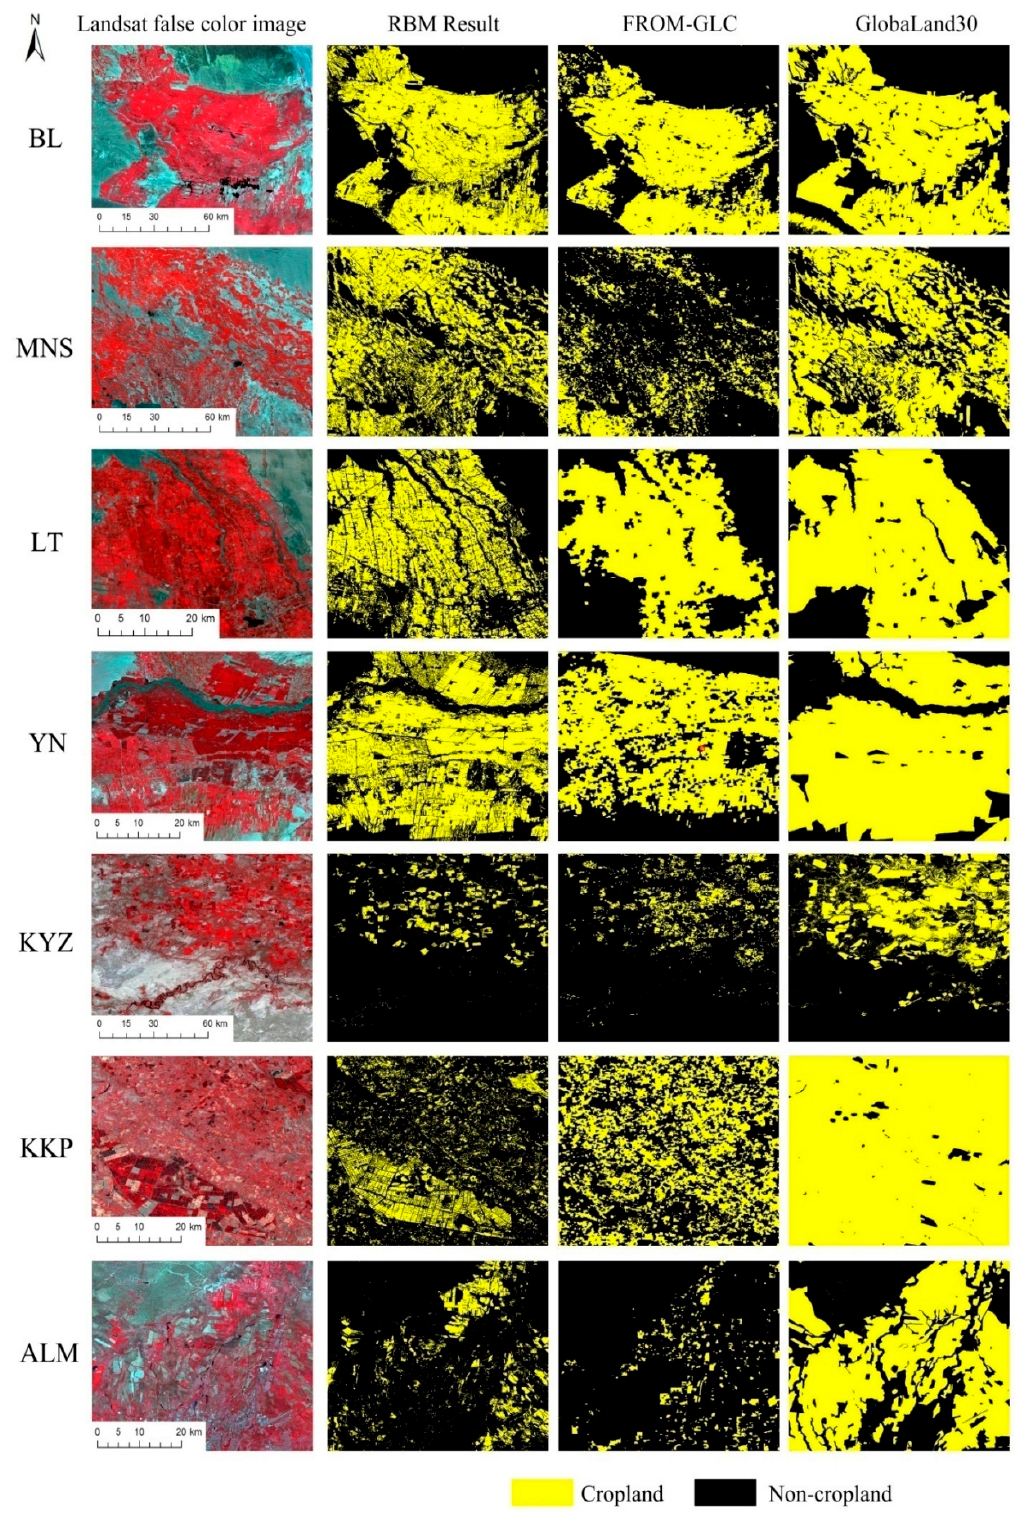
Figure 10. Comparison of the cropland maps in 2010. Note: The images in different study regions have different scale bars in this figure.